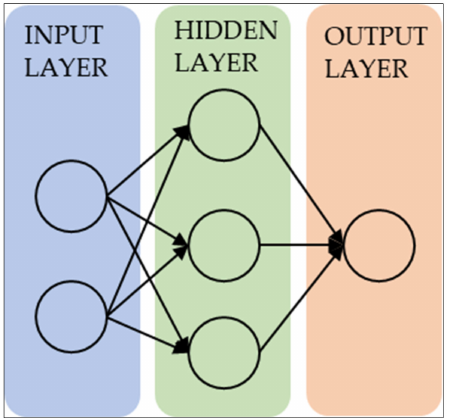
Figure 6. The basic ANN layer with interconnected nodes (reproduced from [73]).